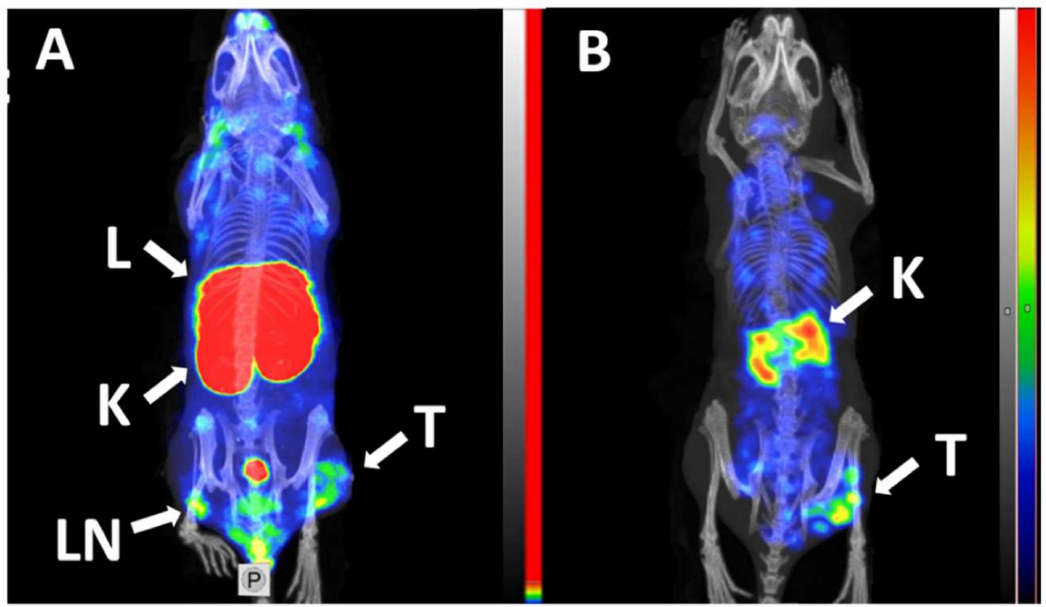
Figure 6. Micro-Single-Photon Emission Computed Tomography / Computed Tomography (microSPECT / CT) imaging of EpCAM expression in BALB / C nu / nu mice bearing EpCAM-positive T—tumor, K—kidneys, L—liver, LN—lymph node. The scale in panel A was adjusted to the first red pixel in the